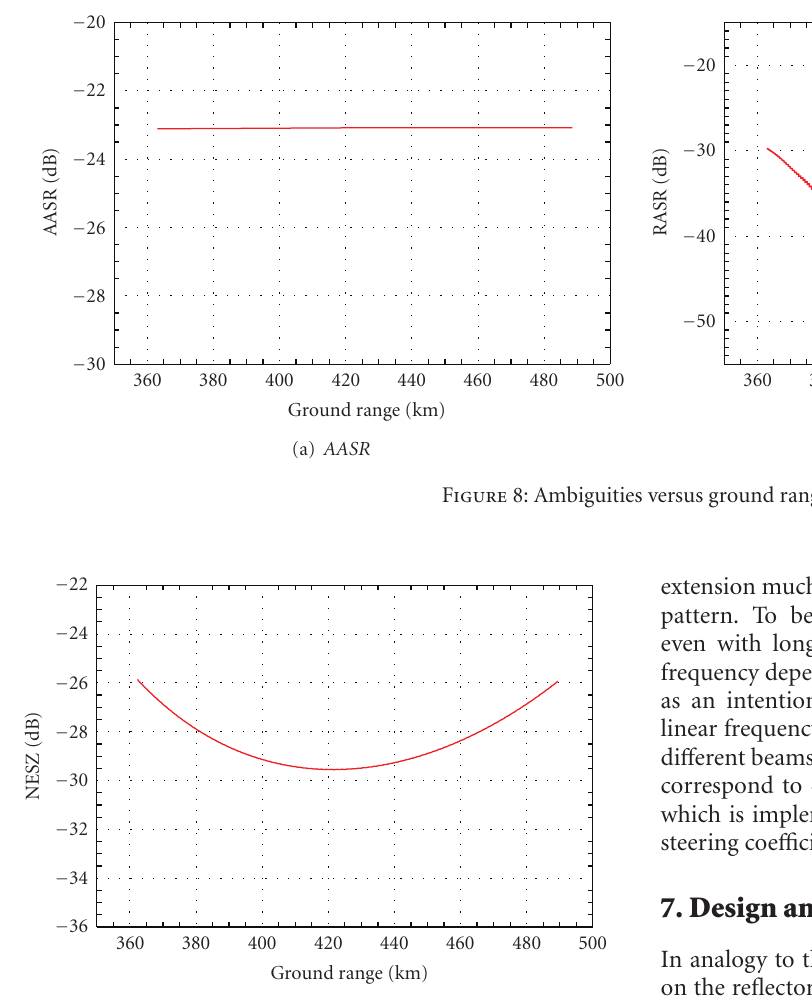
Figure 9: The noise-equivalent sigma zero of the planar system versus ground